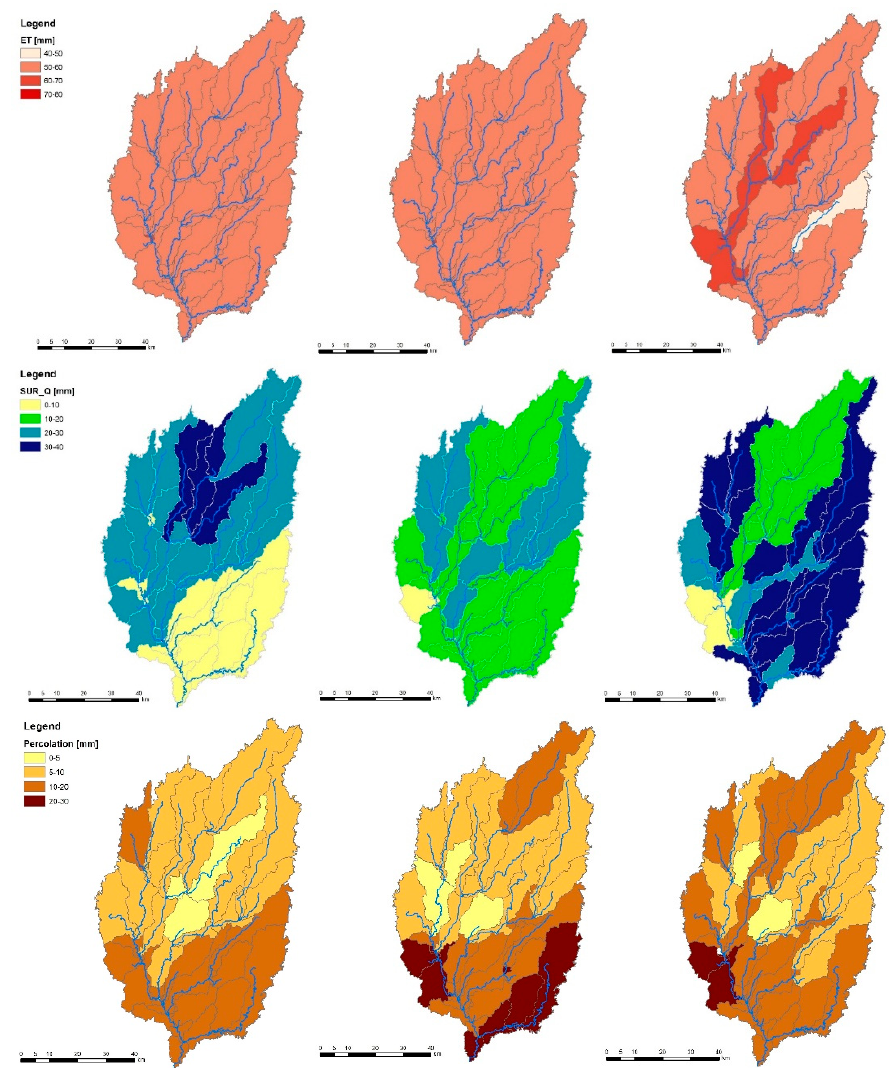
Figure 10. Precipitation, actual evapotranspiration, surface runoff, and percolation maps at subbasin level for each of the configuration periods (C1, C2, and C3) from left to right. All the values presented are in mm.